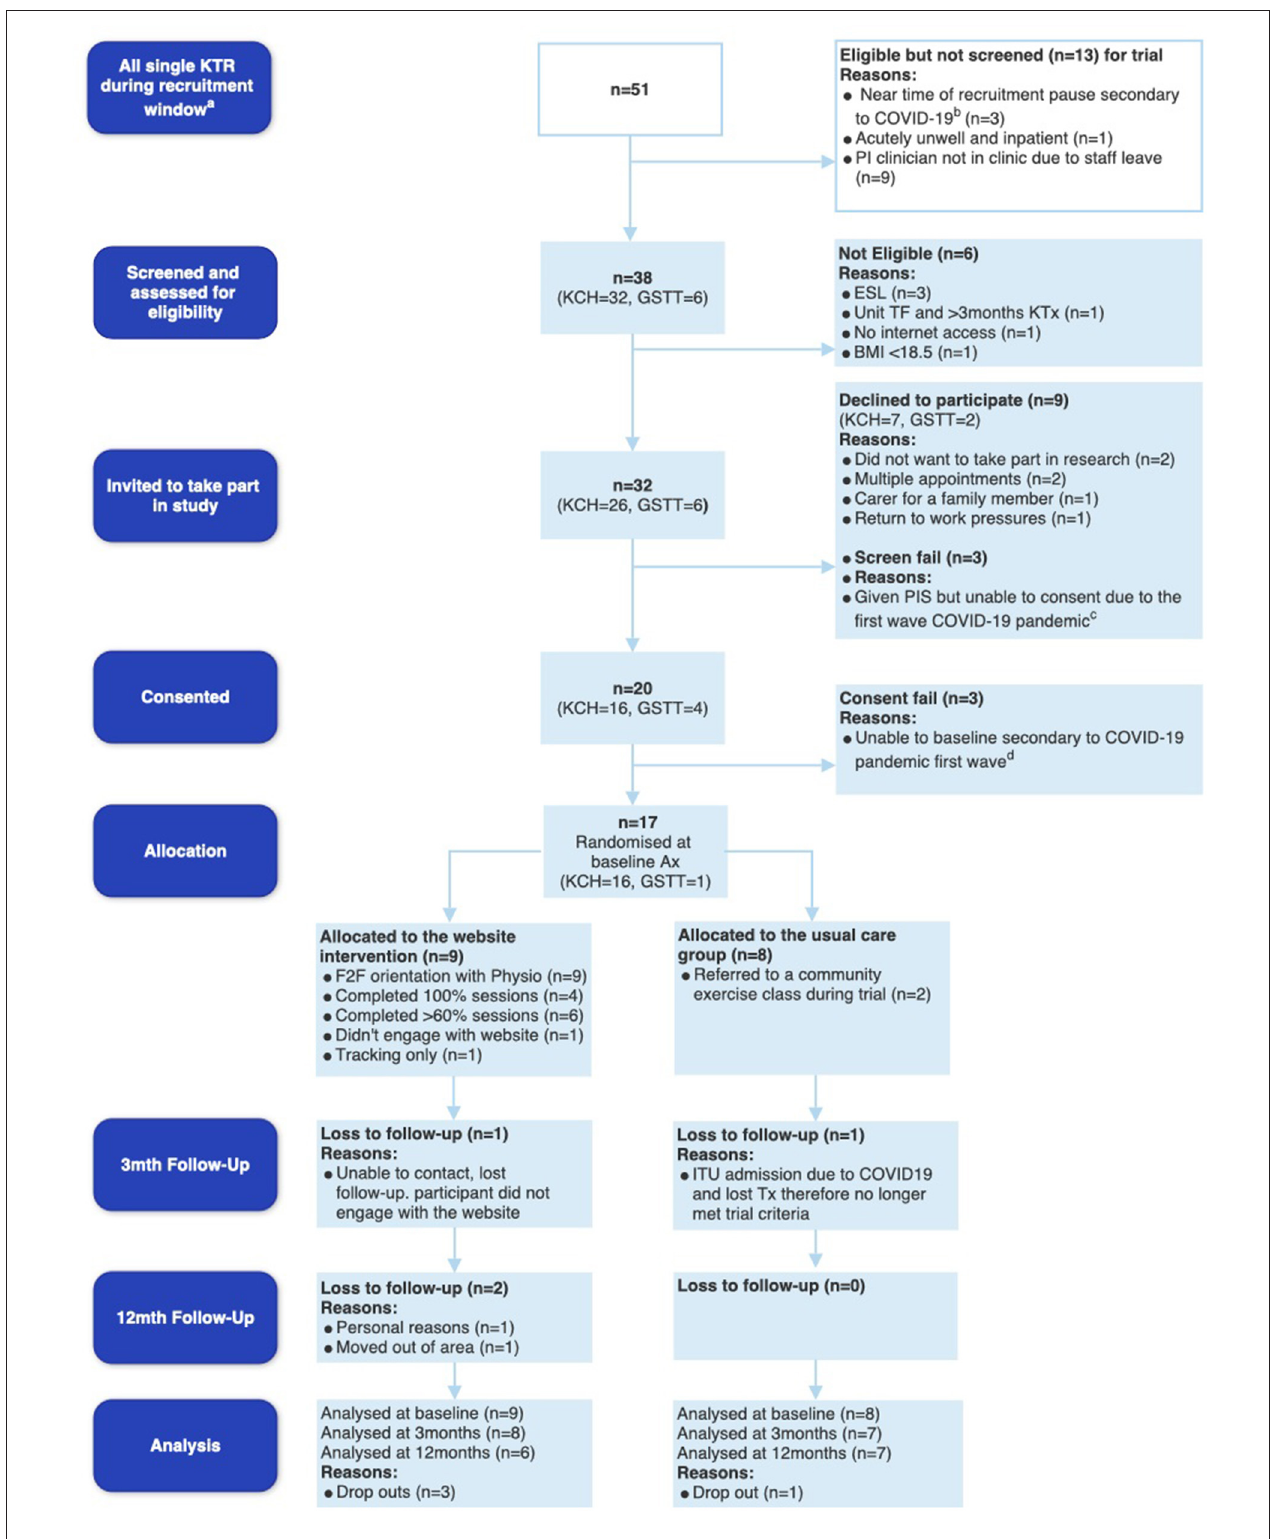
FIGURE 1 | Feasibility CONSORT diagram. a Indicates the recruitment window (3rd September 2019–15th March 2020 for KCH and 19th February − 15th March 2020 for GSTT), b indicates potential participants at KCH who were eligible days before recruitment was put on hold due to Coronavirus disease 2019 (COVID-19)